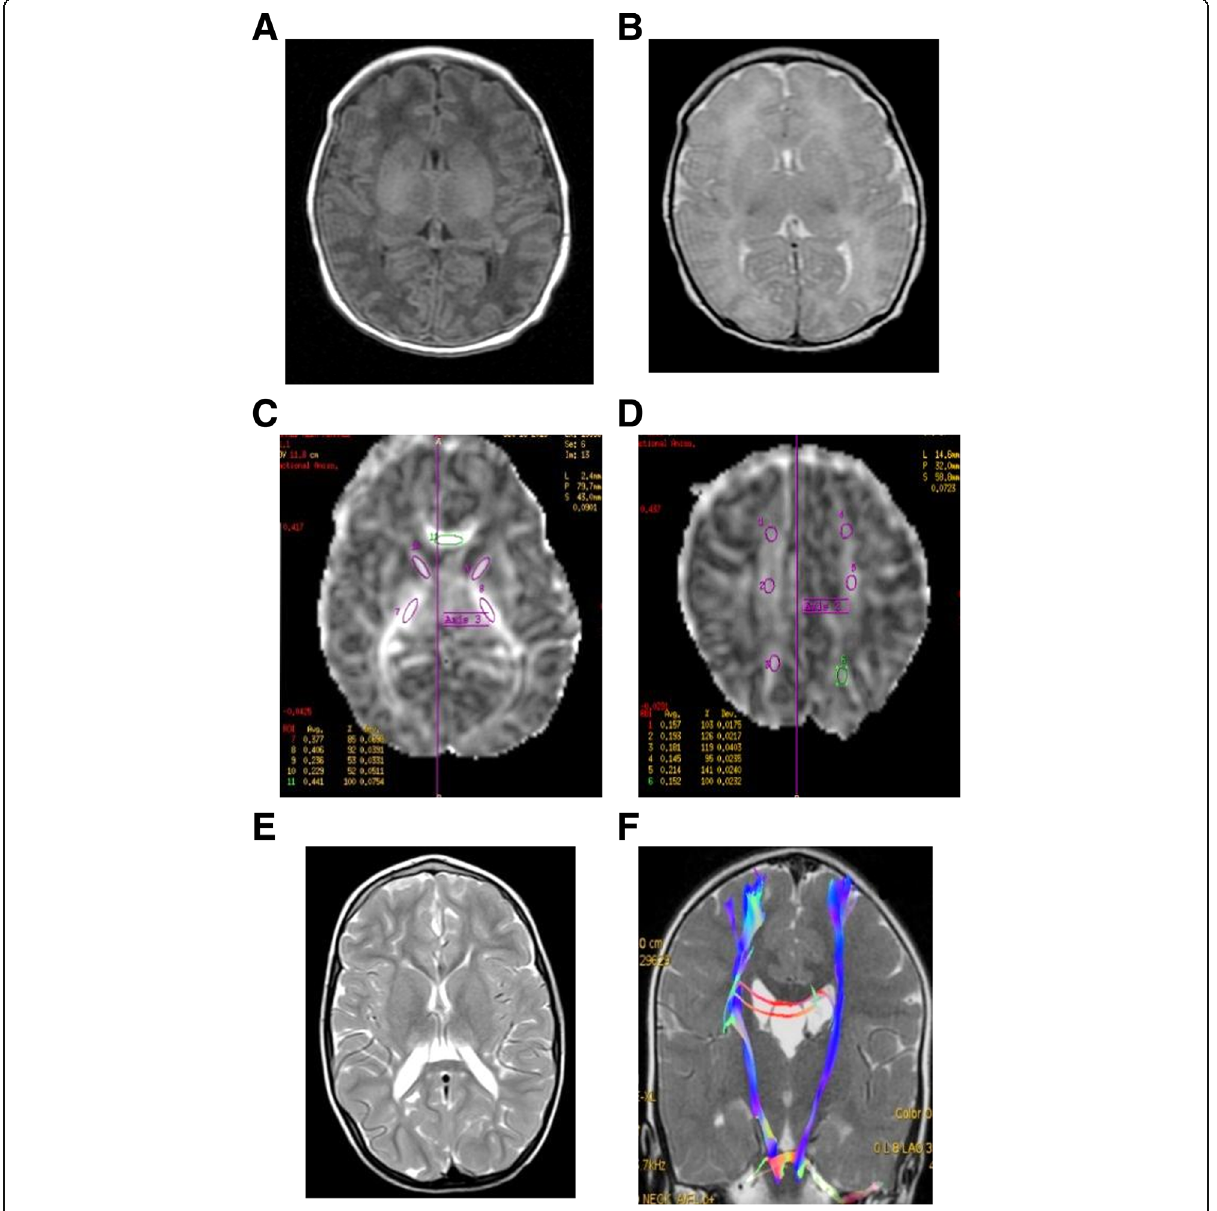
Fig. 3 Nine days neonate presenting with severe HIE picture, Sarnat III with CP outcome. Conventional MRI: a , b axial T1 and T2 showed preserved PLIC signal and distinct gray-white matter differentiation. DTI: c , d posterior limb of internal capsule FA value = 0.37 and centum semiovale FA value = 0.20. Follow-up examination: e axial T2 showed thinning of the peri-trigonal white matter with approximation of the corticoventricular distance (PVL picture). f Tractography showed mild thinning of the corticospinal tracts in CP